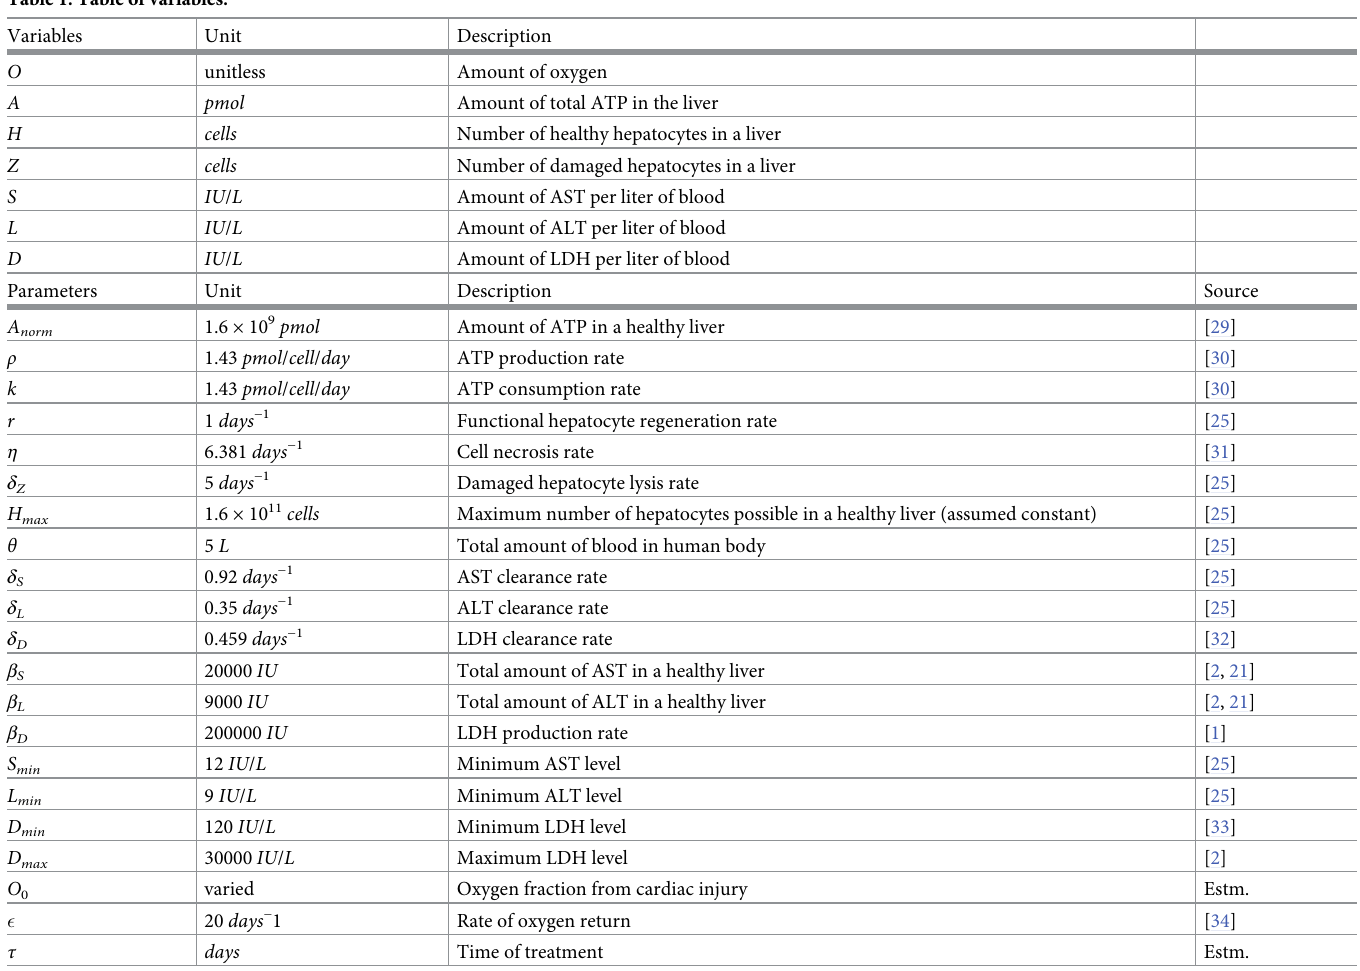
Table 1. Table of variables.